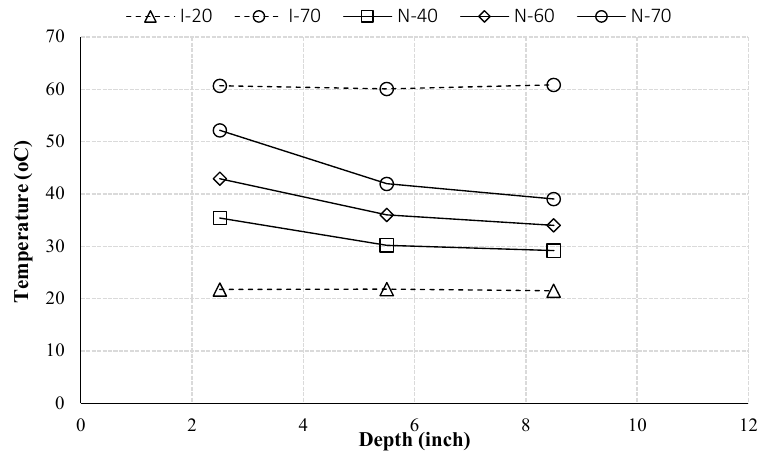
Figure 4. Temperature distribution profiles for all samples at the same time ( t = 10 day).